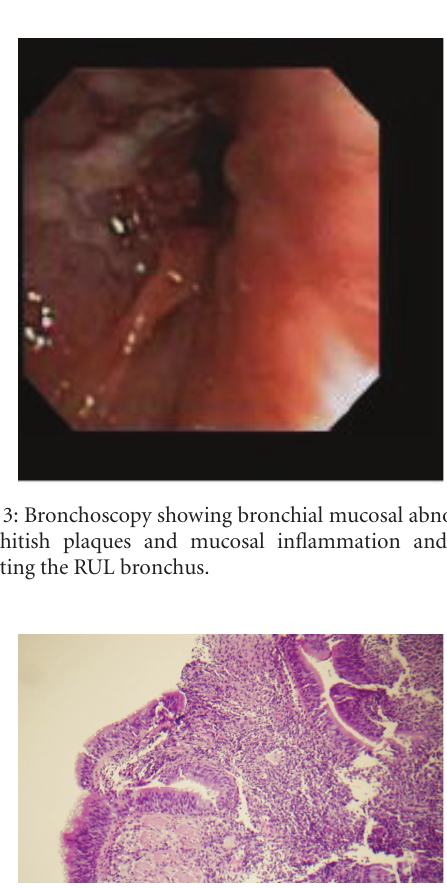
Figure 4: Bronchial biopsy reveals dense infiltration of atypical lymphocytes and histiocytes.